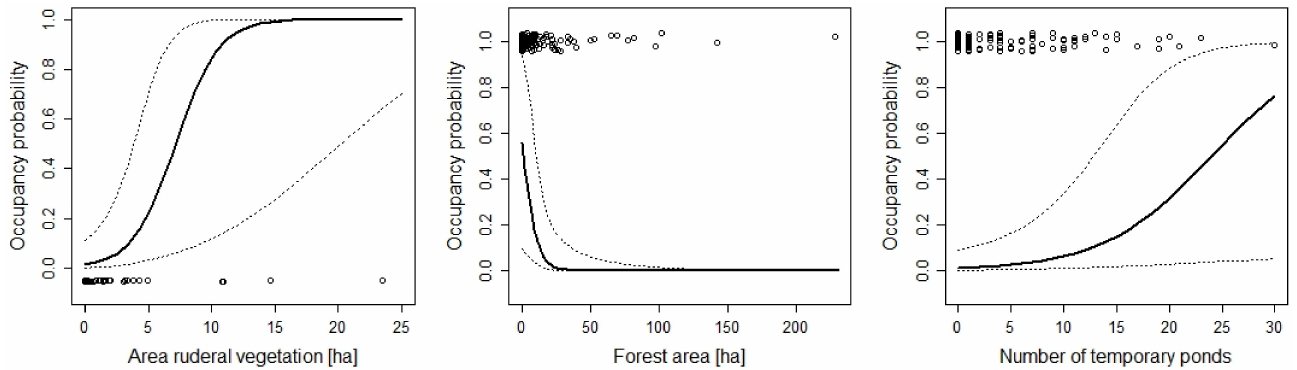
Figure 4. The effects of habitat characteristics on the occupancy probability of Lissotriton helveticus , Hyla arborea , and Bufo bufo . For additional explanations, see the caption of Figure 2.